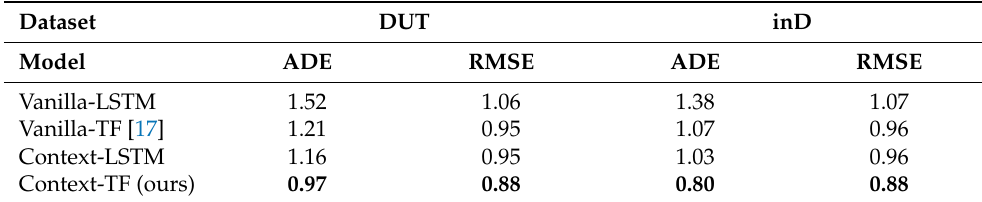
Table 1. The performance of transformer-based approaches in comparison to LSTM-based ap- proaches (w/o context input) for pedestrians’ trajectory prediction over a prediction horizon of 5 s ahead. The reported scores are shown according to the evaluation metrics (ADE/RMSE) in meters. Lower scores are better.